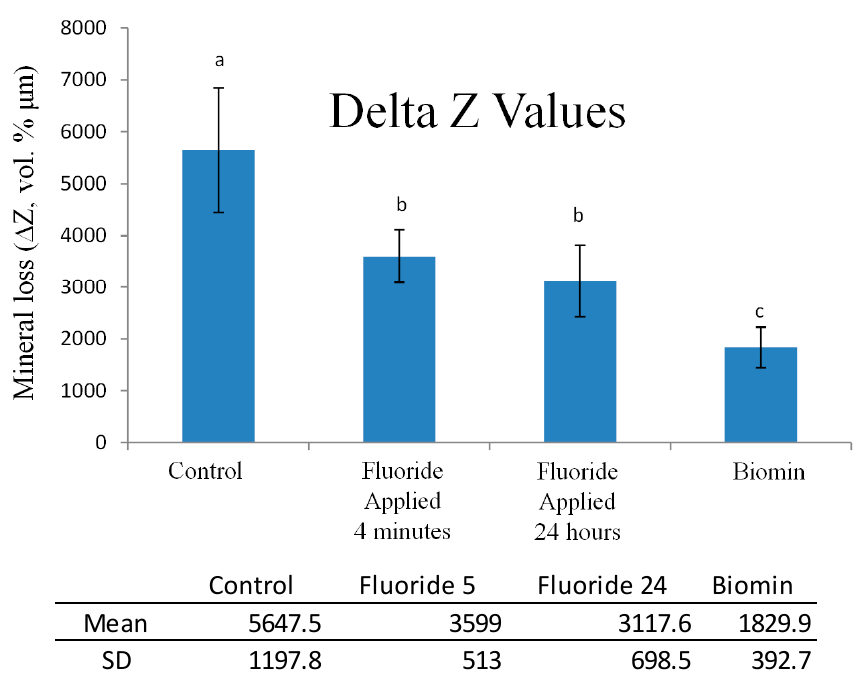
Figure 3. Mineral loss ( Δ Z) after treatment protocols presented by bar chart and Table. Bars with same letters were not statistically significant α = 0.05.